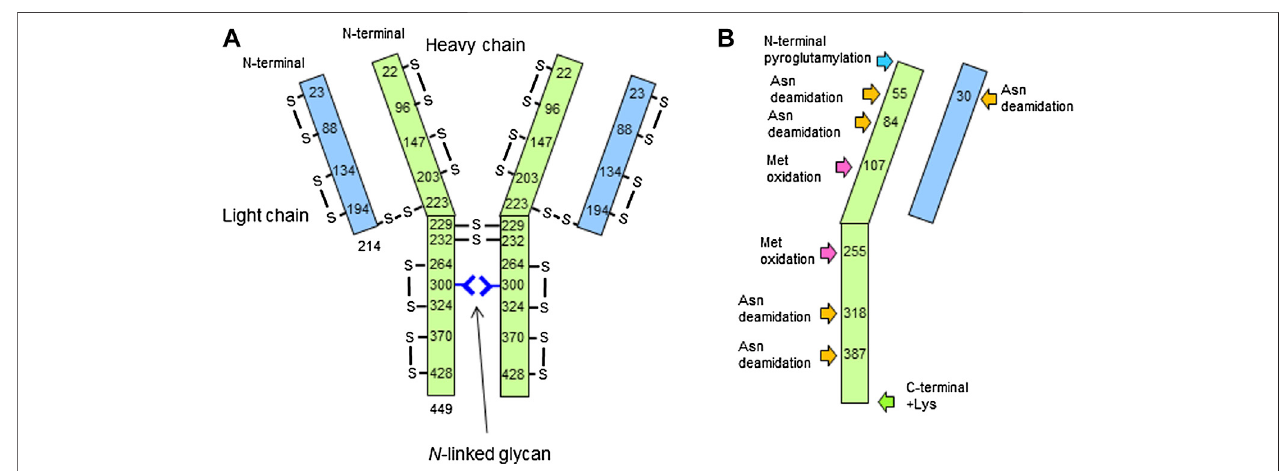
FIGURE8| Structureofthecandidatereferencematerial(RM)determined bythisstudy.Sizeoflightchain(LC)and heavychain(LC),disul fi debondformation,and glycosylation site (A) , as well as N/C-terminal modi fi cations, Asn deamidation, and Met oxidation (B) are described.